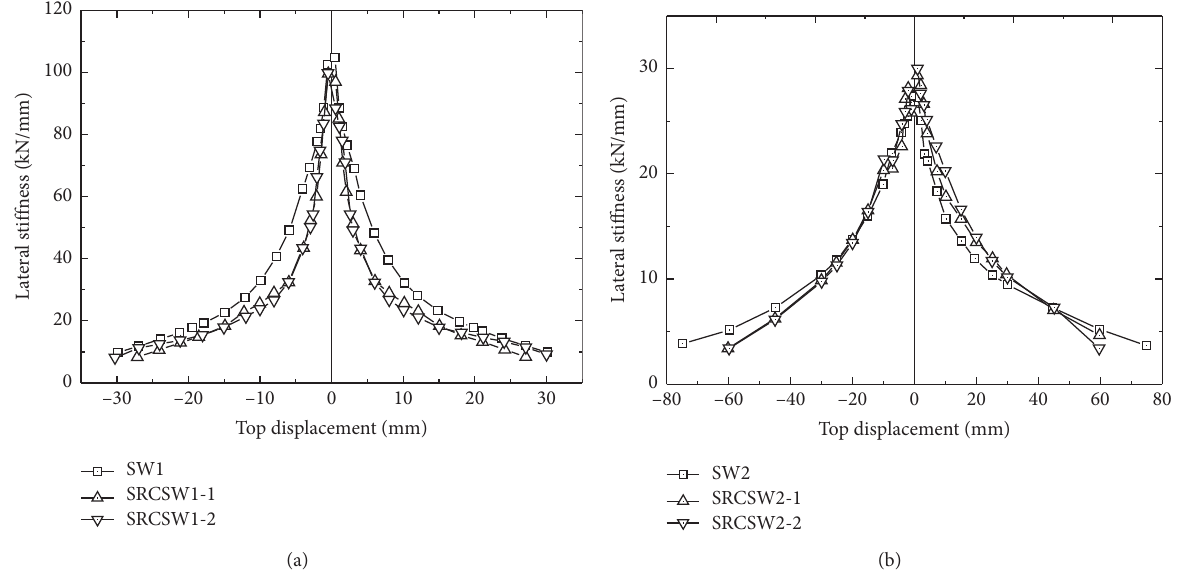
Figure 11: Secant stiffness degeneration curves of specimens. (a) Group 1. (b) Group